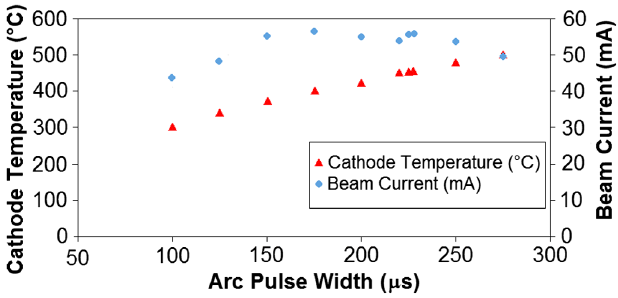
FIG. 8. Beam current and cathode temperature vs arc pulse width using the solenoid gas valve in the H −